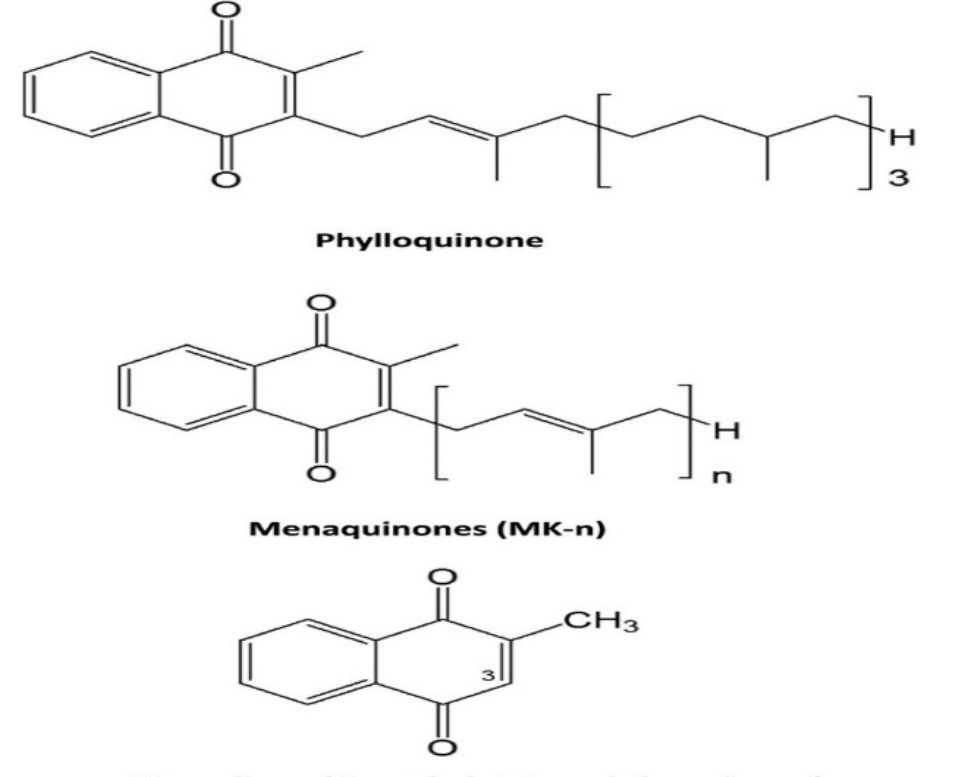
Figure 1. Structure of vitamin K1 (phylloquinone) and vitamin K 2 (menaquinone) Menadion (vitamin K3) represent the common K1 and K2 structure Menadione is a synthetic vitamin K type.